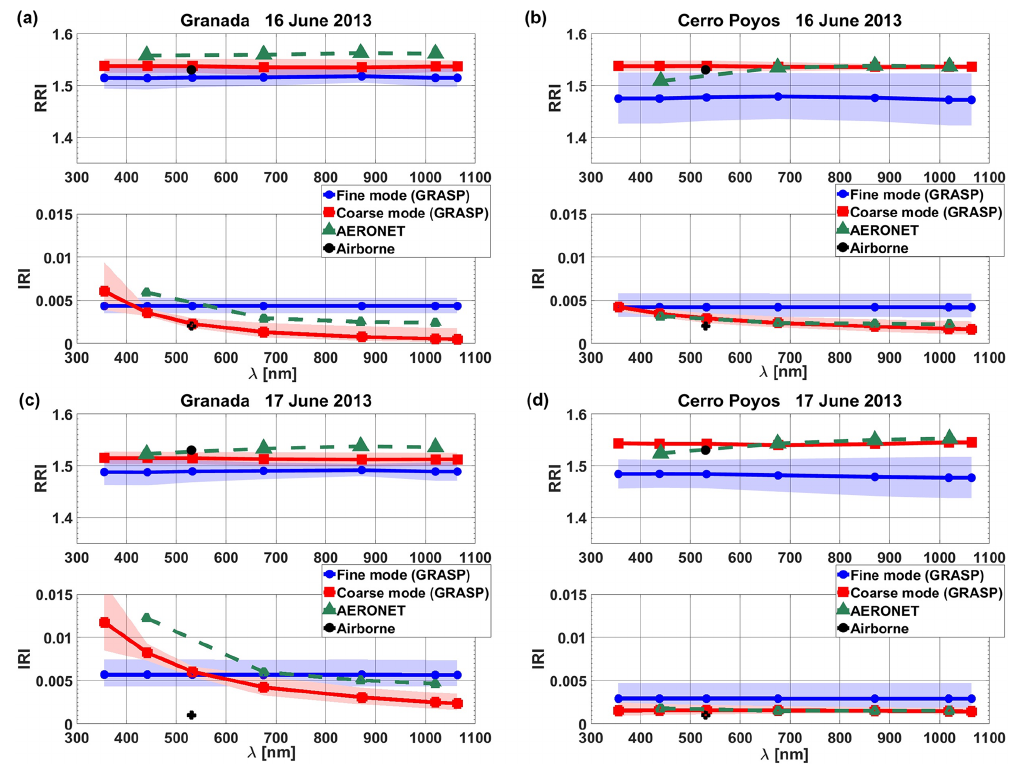
Figure 4. Spectral real (RRI) and imaginary (IRI) refractive indices retrieved by GRASP for the fine (blue) and coarse (red) modes with its uncertainty (shaded area), by AERONET (green) and by airborne measurement (black) on 16 (a, b) and 17 (c, d) June 2013 in Granada (a, c) and Cerro Poyos (b, d)